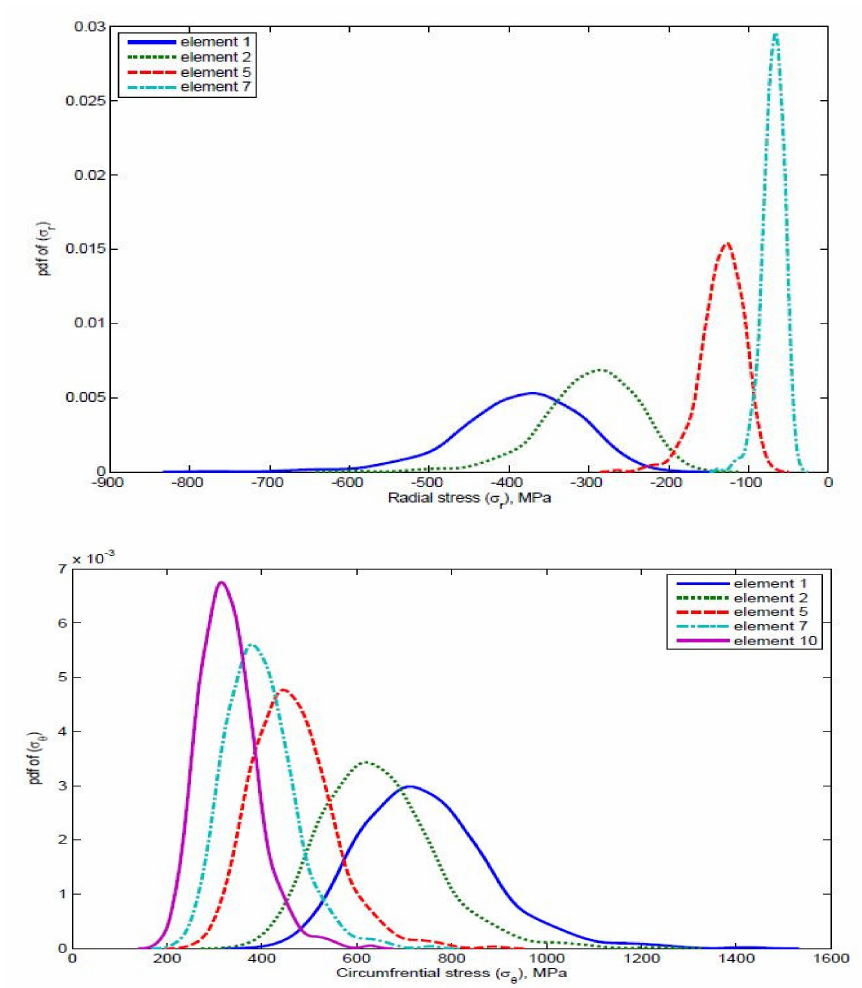
Figure 16. Comparison of radial stress and circumferential stress for different elements where E is a random